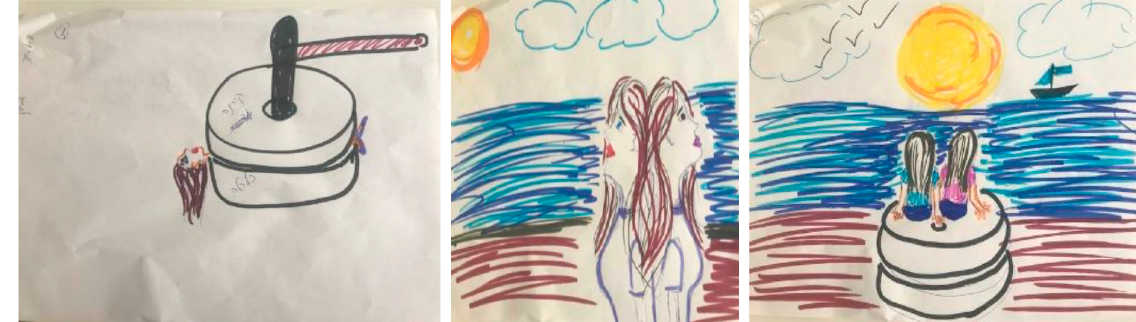
Figure 2. Placing the stress image in a secure context within the integrated drawing.